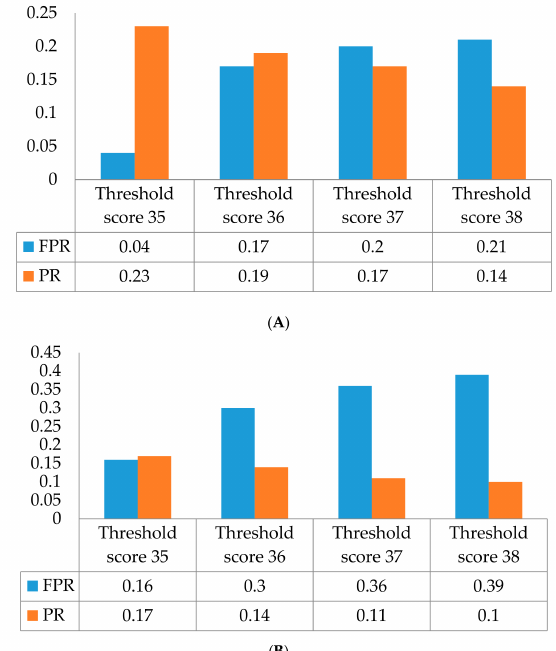
Figure 3. ( A ) It shows the association of the false positive rate (FPR) and prevalence rate (PR) on the threshold score without jogging intervention by the binary logistic model on the condition of cutoff 2.5 for factor score estimate. ( B ) It shows the association of the FPR and the PR at different threshold scores with jogging intervention by logistic model on the condition of cutoff 2.5 for emotional factor score